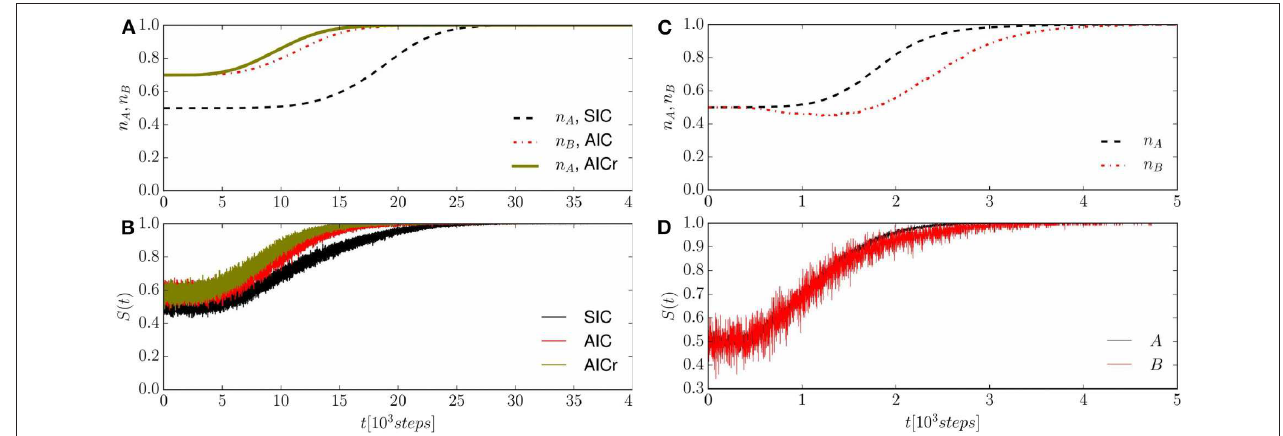
FIGURE 4 | Average population fraction associated to the name shared in the final consensus state (A,C) and success rate S ( t ) (B,D) vs. time. (A,B) System with N 1,000 agents starting from different initial conditions, SIC, AIC, and AICr; averages obtained over 600 runs. (C,D) System with N = averages obtained over 1,000 runs—notice that due to the smaller size N p e , A 0.9) and with name B ( p e , B 0.1). ≈ ≈